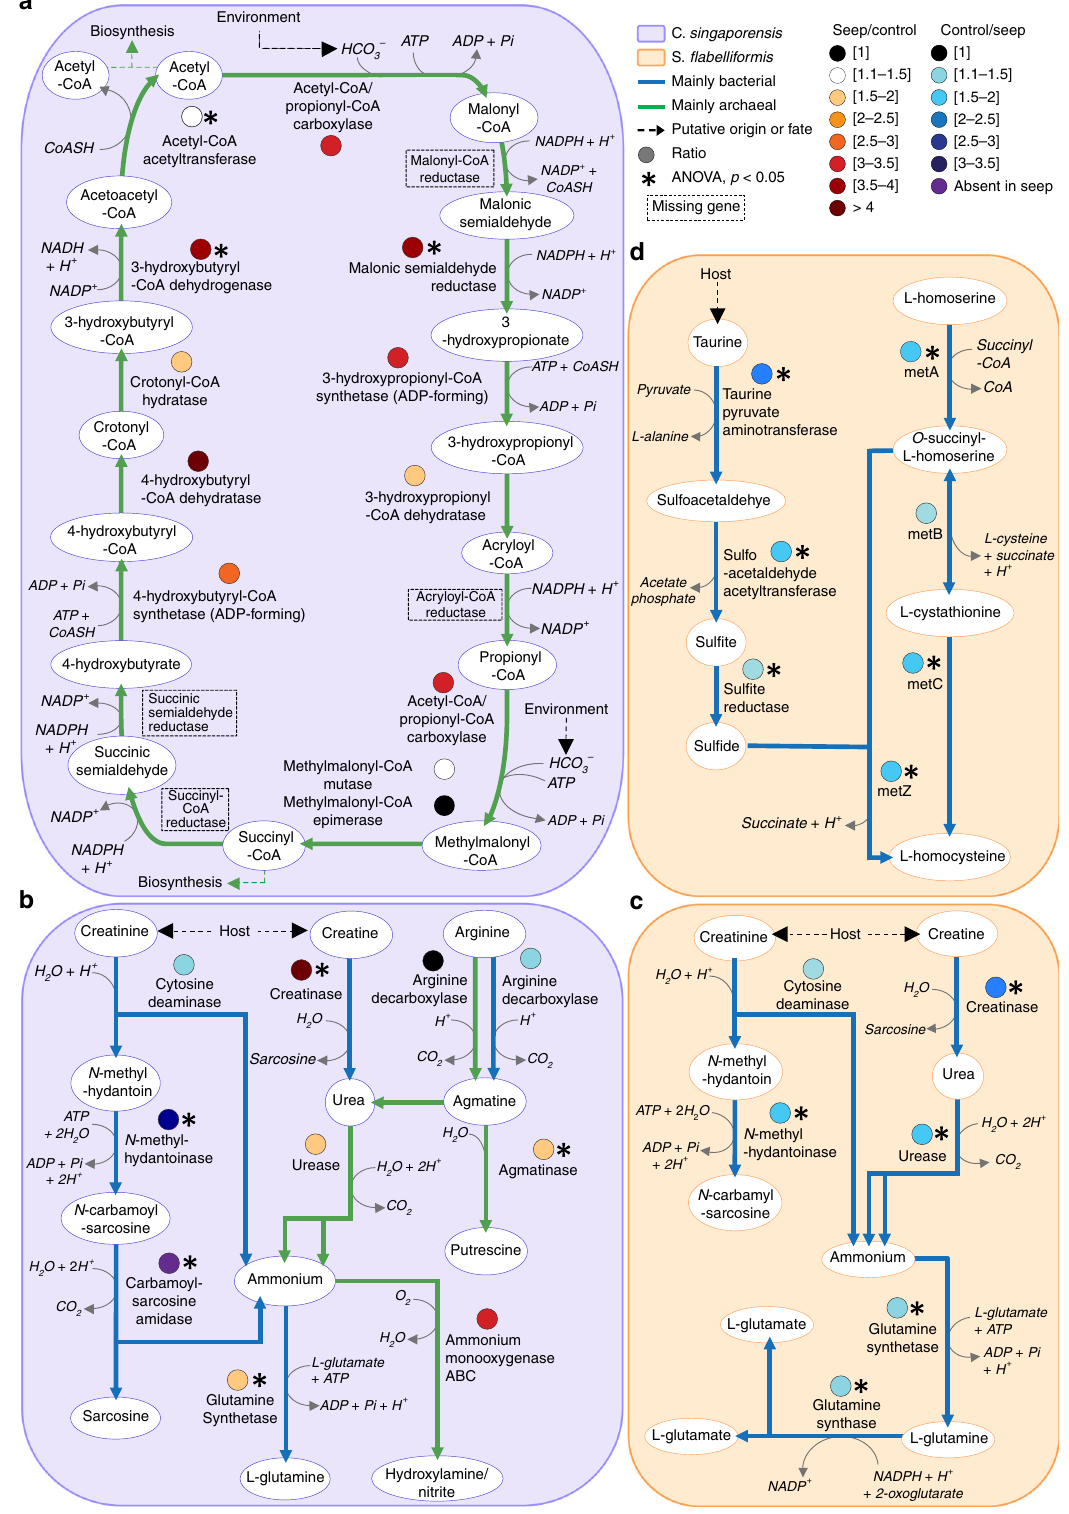
Fig. 3 Microbial metabolic pathways related to carbon, nitrogen and sulfur metabolism. a Carbon fi xation via HP/HB cycle (see Supplementary Methods for detail of KO assignment to functions). b and c Degradation and utilisation of nitrogen compounds. d Sul fi de assimilation following taurine degradation. P -values (represented by asterisks) were derived from ANOVA. Line colours represent taxonomic origin and coloured circles represent ratios of relative abundances, all according to the colour scale described in the fi gure